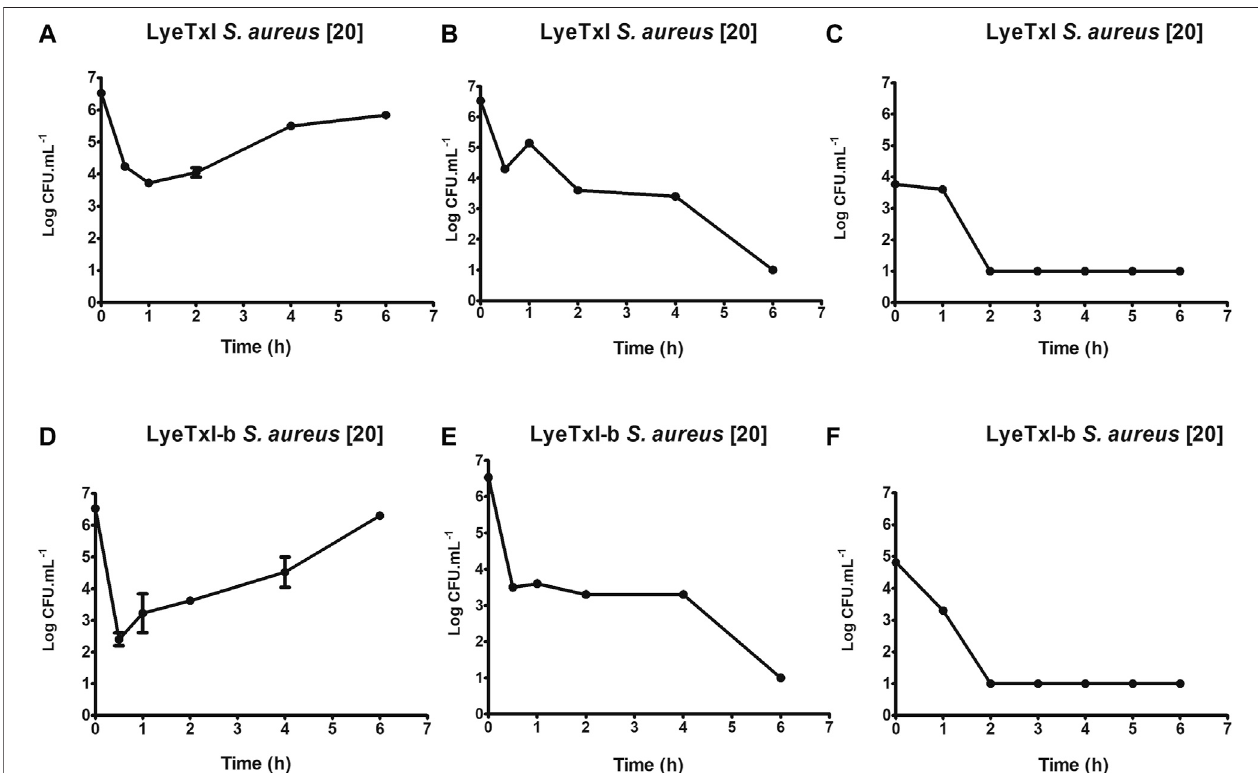
FIGURE 4 | Kinetics of growth and time-dependent killing. S. aureus [20] was incubated with LyeTxI [½, 1 and 2 MICs (cid:2) 1.4, 2.8, and 5.6 μ mol L − 1 ; Panels (A – C) respectively], or with LyeTxI-b [½, 1 and 2 MICs (cid:2) 0.72, 1.44 and 2.88 μ mol L − 1 ; Panels (D – F) , respectively]. The incubations were at 37 ° C for 0.5 1, 2, 4, and 6 h. The density of viable cells was estimated at UFC.ml − 1 using the microtip